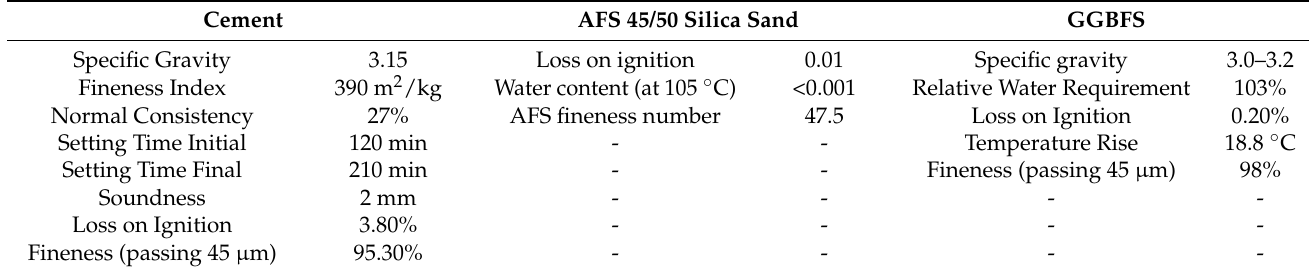
Table 3. Physical properties of cement, silica sand and ground granulated blast furnace slag.